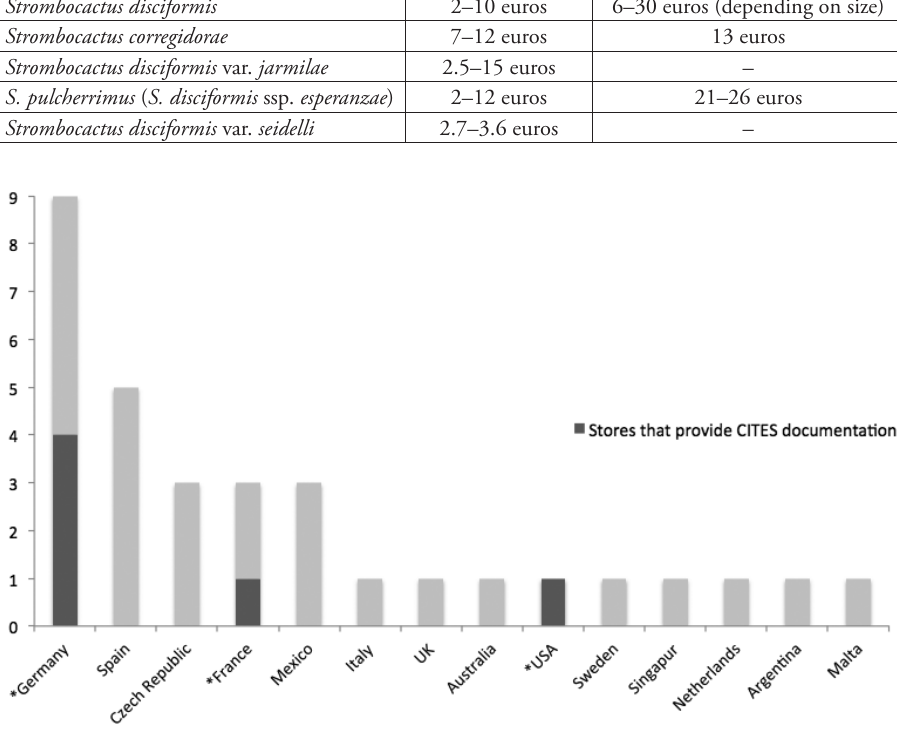
Figure 1. Number of online stores per country that sell Strombocactus . The asterisk (*) represents countries where at least one online store offers CITES certified cacti. Table 2. Number of online stores localities (abbreviated state in